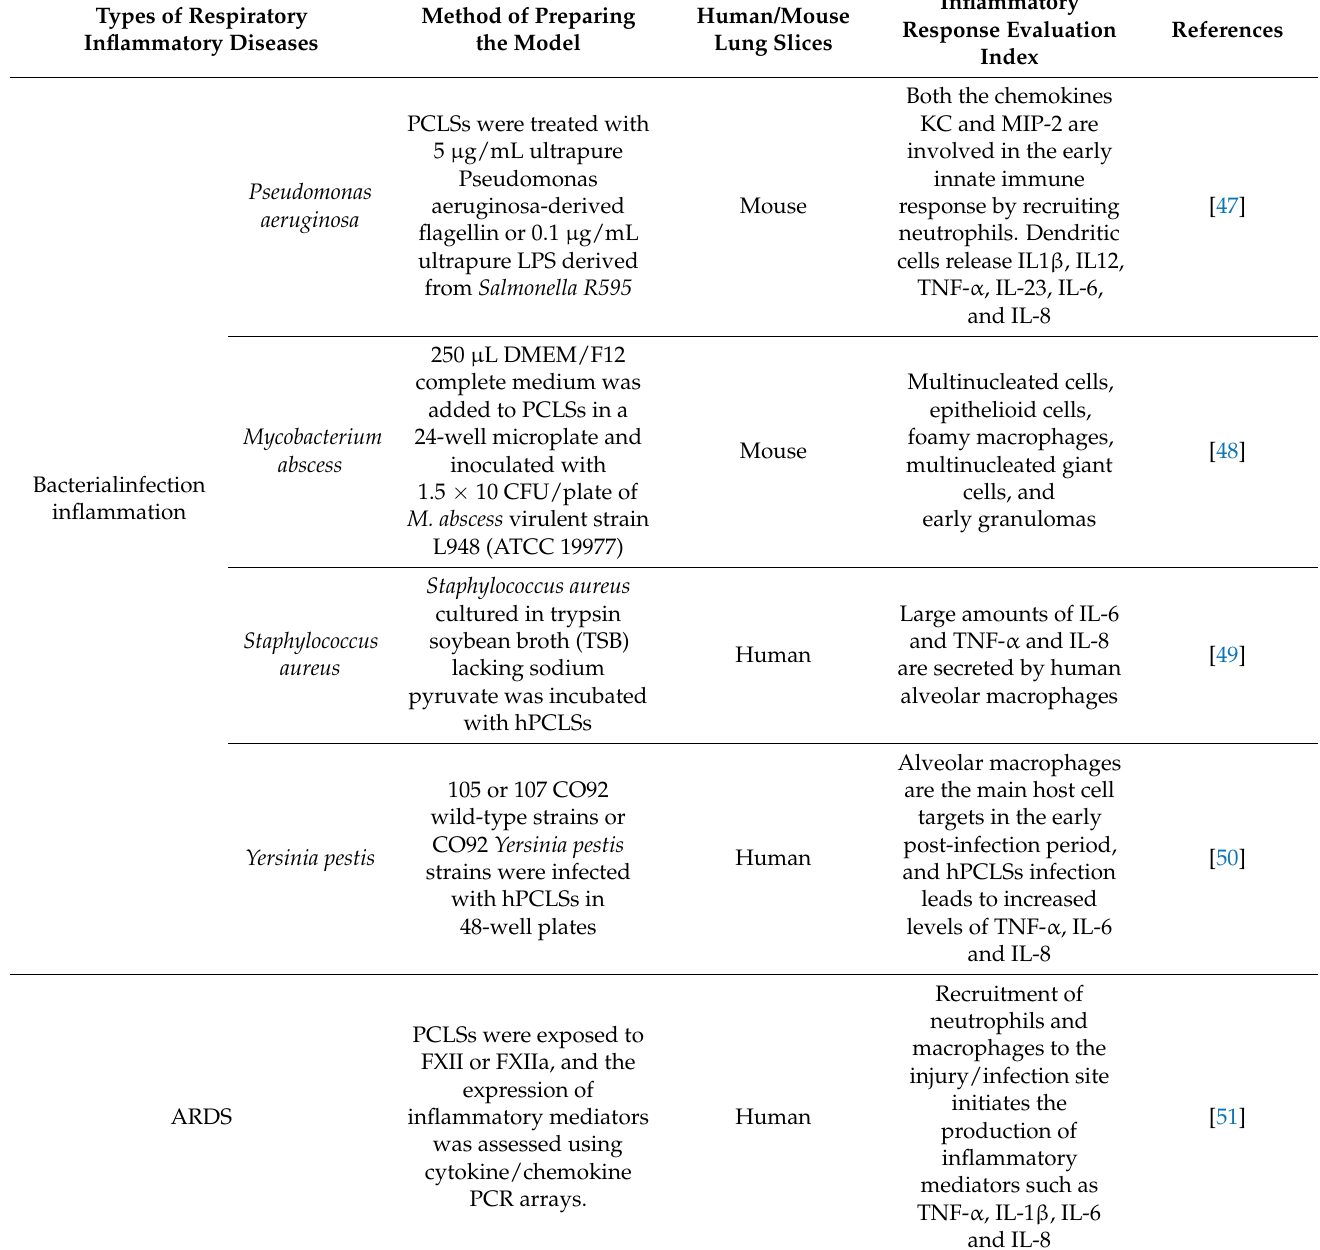
Table 1. Detection of inflammatory cells and factors in lung